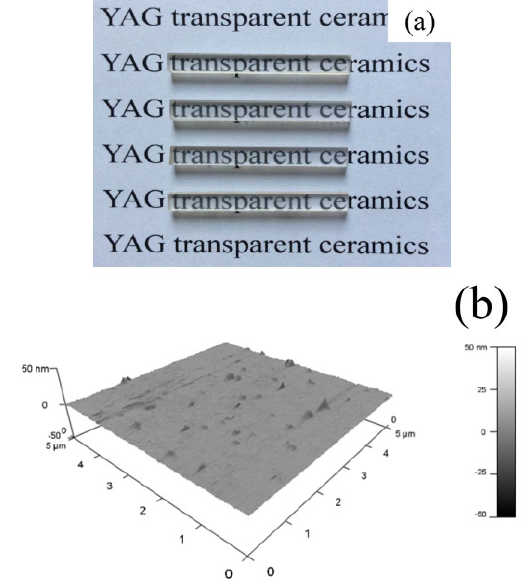
Fig. 7 (a) Photo and (b) surface morphology of YAG transparent ceramic specimens carried out bending fracture test.